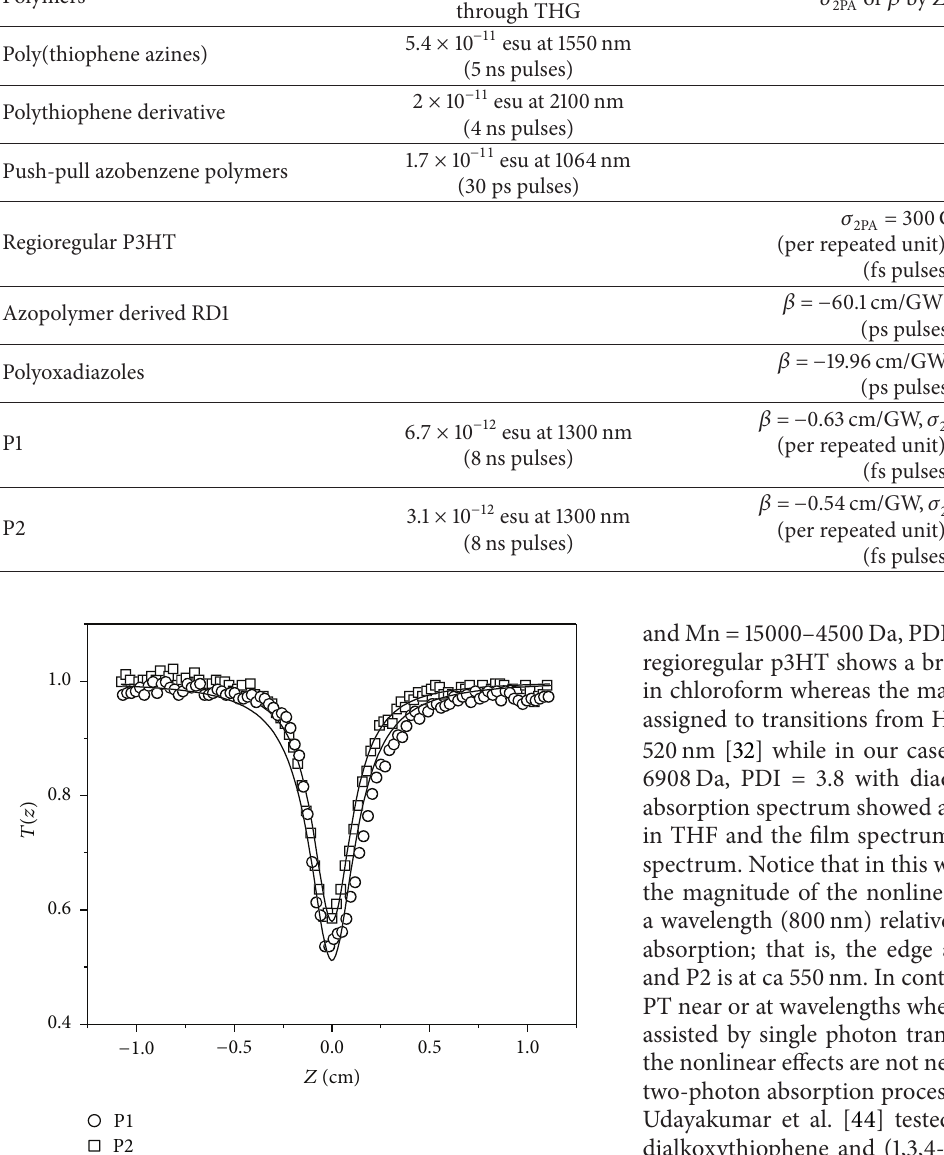
Figure 7: Open-aperture 𝑍 -scan measurements for solutions of copolymers P1 and P2 (3 × 10 −3 M) in chloroform under femtosec- ond excitation (800nm) with peak intensity of 22 GW/cm 2